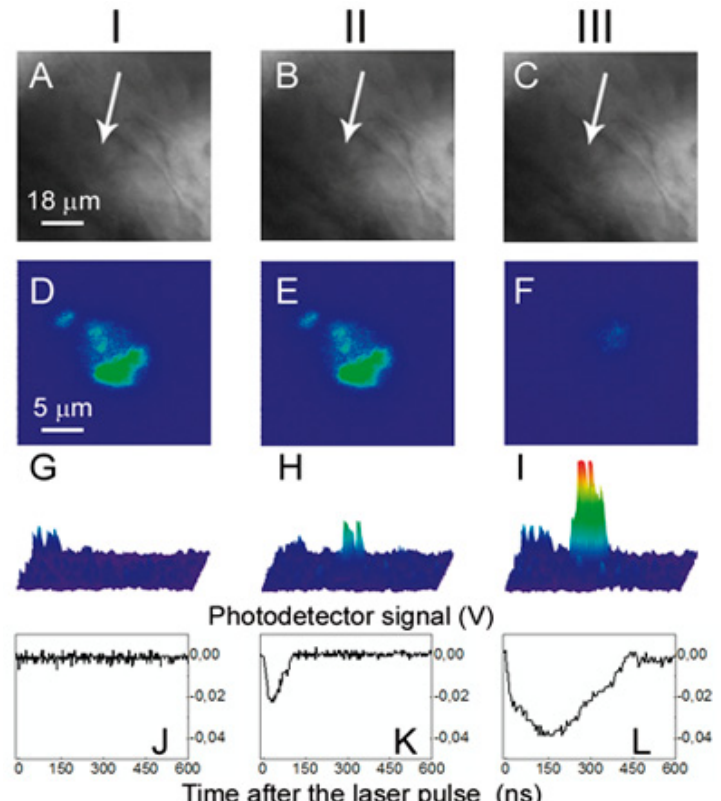
Figure 19. Images of the zebrafish embryo with prostate cancer cells incubated with gold NPs and DiI dye: I: before PNB, II: after the 1st PNB, III: after the 2nd PNB; ( a-c ) bright field images; ( d–f ) fluorescence of DiI (( d ) before PNB, ( e ) after 1st PNB, ( f ) after 2nd PNB); ( g–i ) side scattering pulsed images of the cell ( g ), 1st PNB ( h ) and 2nd PNB ( i ); ( j–l ) corresponding time-responses obtained simultaneously with scattering images ( g–i ). Cancer cell shown with an arrow